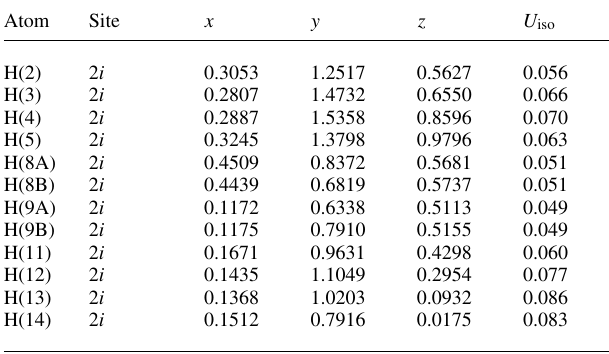
Table 2. Atomic coordinates and displacement parameters (in Å 2 ) .